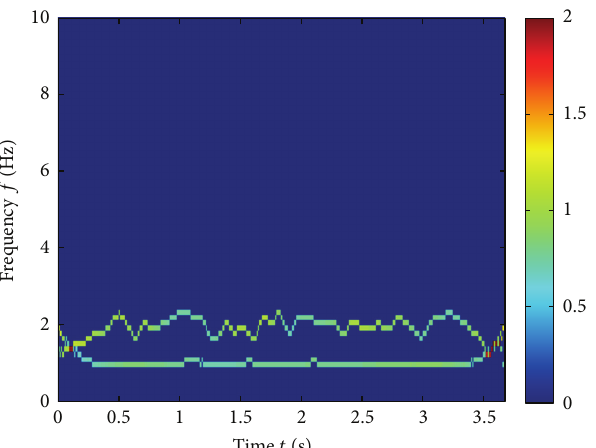
Figure 7: Hilbert spectrum of the simulated signal 𝑧(𝑡) after improved EMD